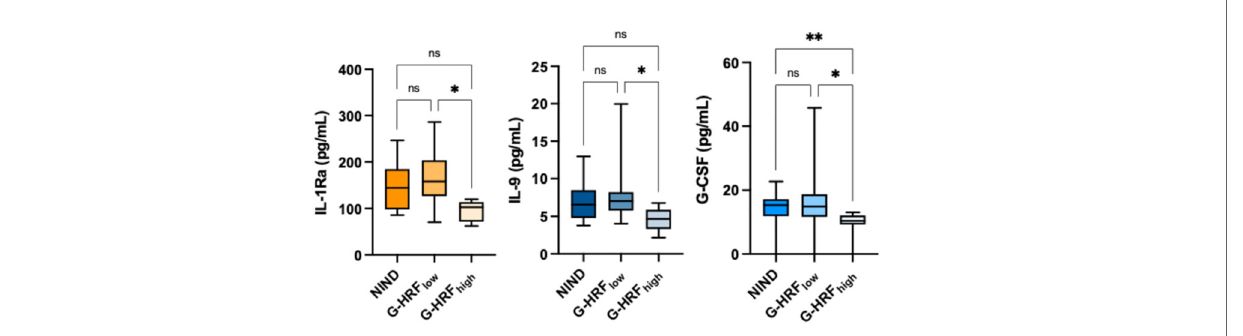
FIGURE 1 | GCL HRF count associates with monocyte-derived CSF cytokines. ONIND, other non-in fl ammatory neurological diseases; G-HRF low , RRMS patients with GCL HRF count ≤ 8.5; G-HRF high , RRMS patients with GCL HRF count > 8.5; *p < 0.05; **p < 0.01. n.s., not signi fi